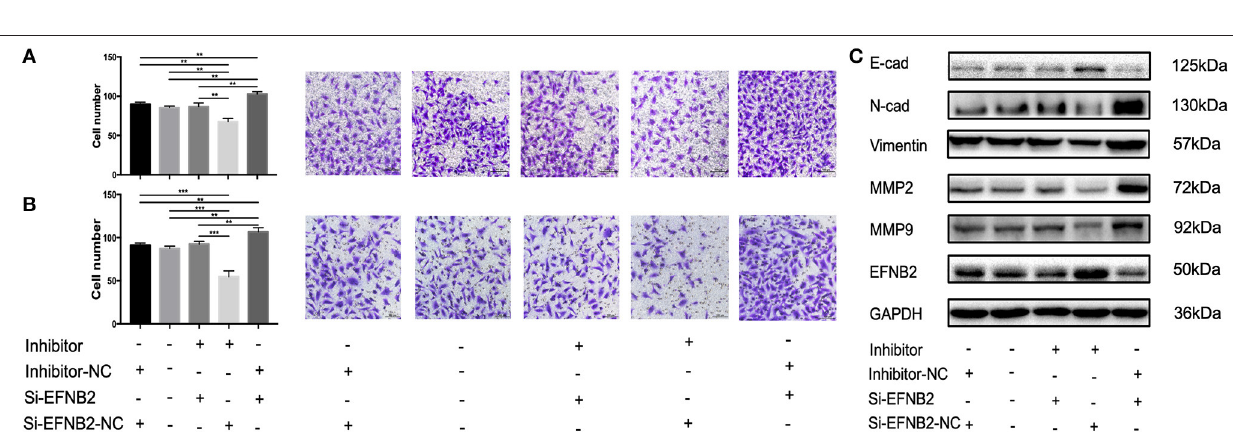
FIGURE 5 | miR-193a-3p regulates the migration and invasion abilities of HTR-8/SVneo cell lines by targeting EFNB2 via the EMT pathway. Migration and invasion abilities of HTR-8/SVneo cells transfected with miR-193a-3p-inhibitor, miR-193a-3p-inhibitor-NC, si-EFNB2, or si-EFNB2-NC examined by Transwell migration assay (A) and Transwell invasion assay (B) . (C) After transfection, the levels of EFNB2 and EMT-related proteins were detected. All data are presented as the mean ± standard deviation. EFNB2, Ephrin-B2; inhibitor, miR-193a-3p inhibitor; Si, siRNA; NC, negative control; EMT, epithelial-mesenchymal transition. ** P < 0.01 and *** P <